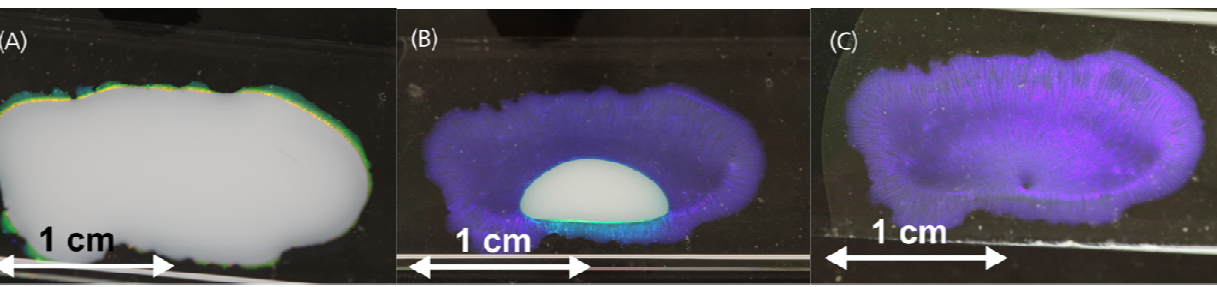
Figure 1. Photo of drop-cast polystyrene microspheres, and effect of evaporation of water. ( A ) after 24 h; ( B ) after 48 h; ( C ) after 72